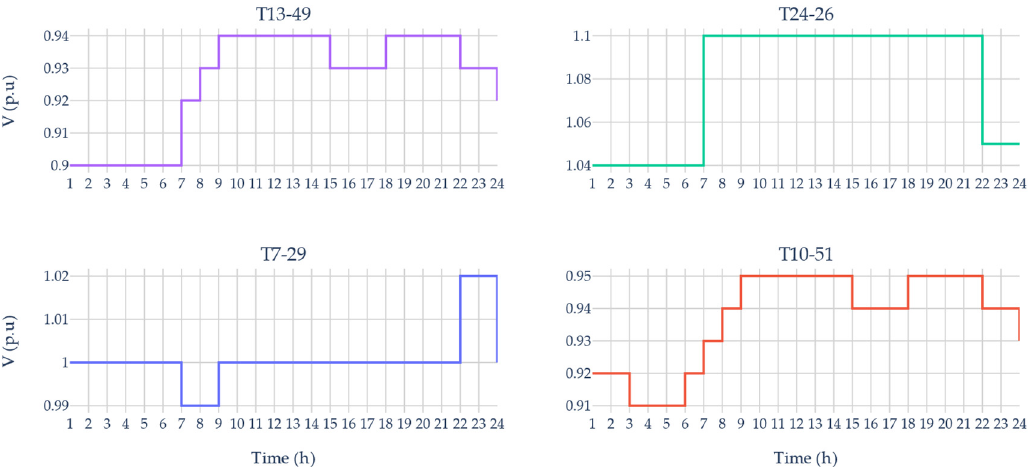
Figure 6. Tap position settings over one operation day (values expressed in p.u) for the IEEE 57-bus test system.